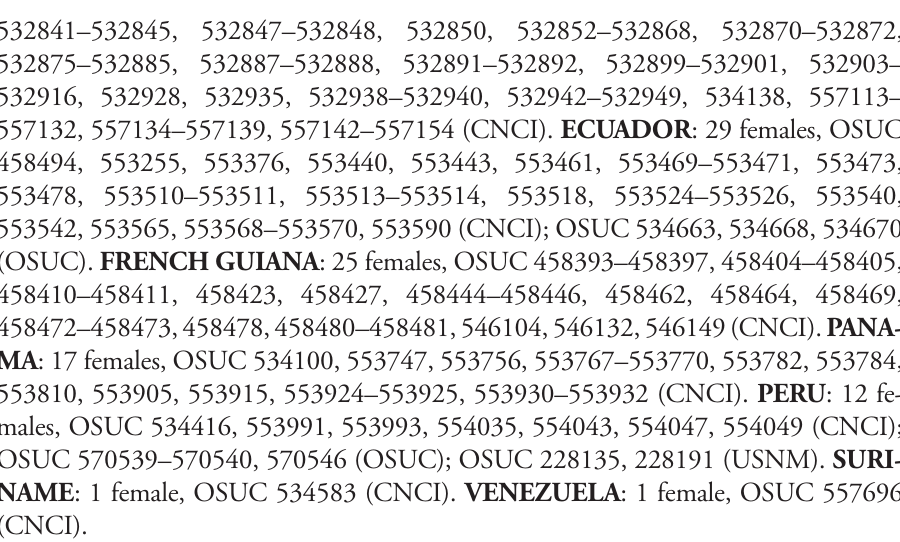
head: subglobose. Central keel of frons: absent. Setation of upper frons: with sparse, long setae. IOS/EH: IOS distinctly less than EH. Sculpture of ventrolateral frons: smooth to granulate. Sculpture of frons below median ocellus: granulate. Sculpture of posterior vertex: granulate to rugulose above hyperoccipital carina, smooth below. Hy- peroccipital carina: present. Occipital carina medially: interrupted. Length of OOL: less than 0.5× ocellar diameter. Sculpture of postgena behind outer orbit: with a carina along outer orbit. Ocular setae: absent. A4 in female: distinctly shorter than A3. A5 in female: shorter than A3, as long as wide. Shape of female A6: distinctly wider than long. Form of male antennal flagellomeres: filiform, A11 approximately 3.0× longer than wide. Length of A5 tyloid in male: longer than 0.5× length of A5. Color of mesosoma in female: orange throughout. Color of mesosoma in male: orange throughout; variably orange to pale brown. Sculpture of dorsal pronotal area: rugose. Sculpture of lateral pronotal area: smooth throughout. Sculpture of netrion: smooth. Notaulus: percurrent or nearly so. Sculpture of mesoscutum: granulate. Shape of mesoscutellum: semiellipsoidal. Foveolae of scutoscutellar sulcus between notau- li: smaller than those along margin of axilla. Sculpture of mesoscutellum: granulate. Shape of metascutellum: posterior margin rounded, 2.5× wider than long.